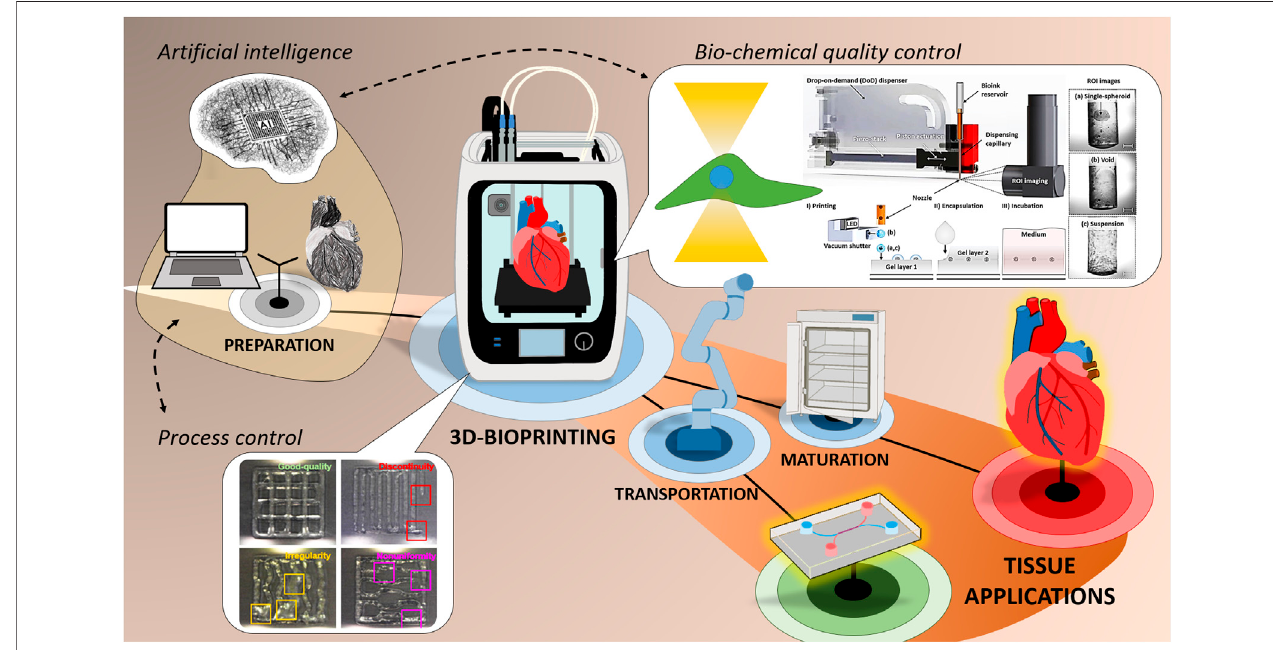
FIGURE 1 | General 3D-Bioprinting process chain and illustration of hardware components with examples for the use of QA-Sensors towards live anomaly detectionforprocesscontrol(reprinted(adapted)withpermissionfrom(Jinetal.,2021).Copyright2021AmericanChemicalSociety)aswellastheuseofROIimagingfor bio-chemical quality control (Tröndle et al.,